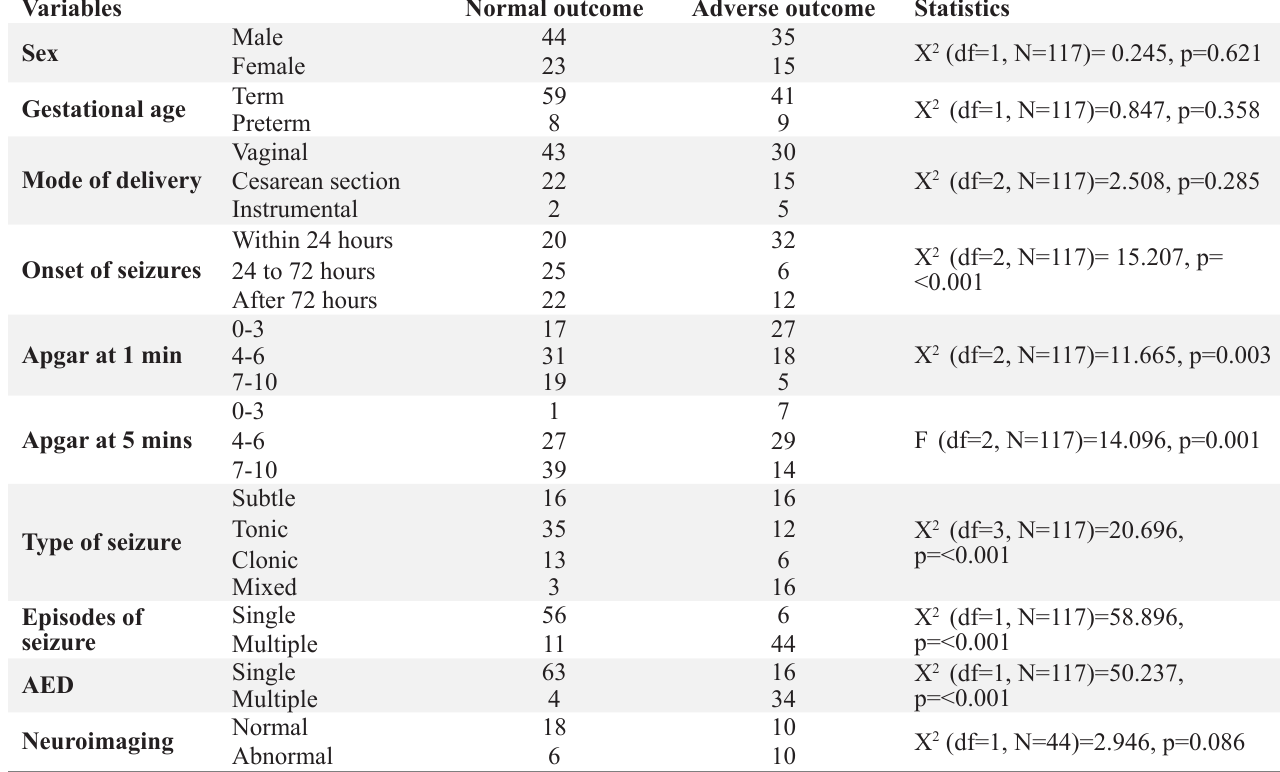
Table 1. Outcome of neonatal seizures in different clinical conditions (N=117)